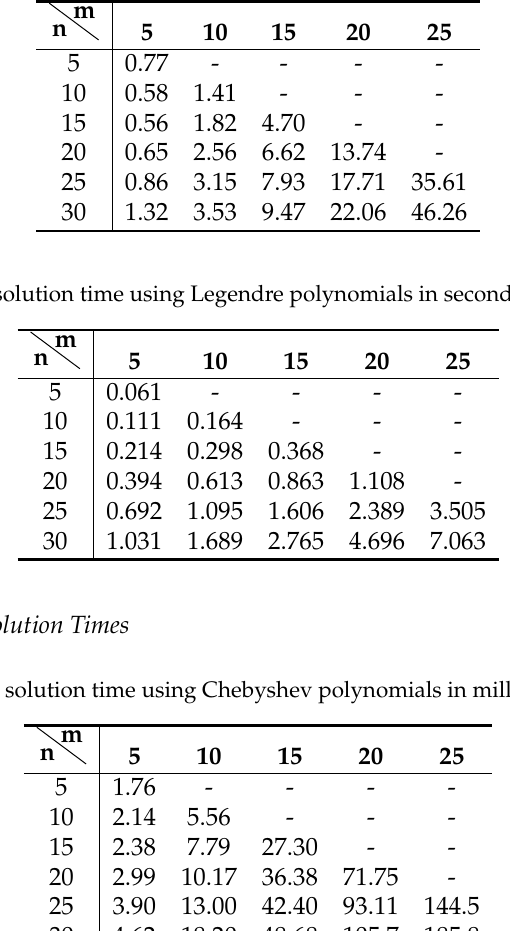
Table A3. Least-squares solution time using Legendre polynomials in milliseconds for Problem #1.